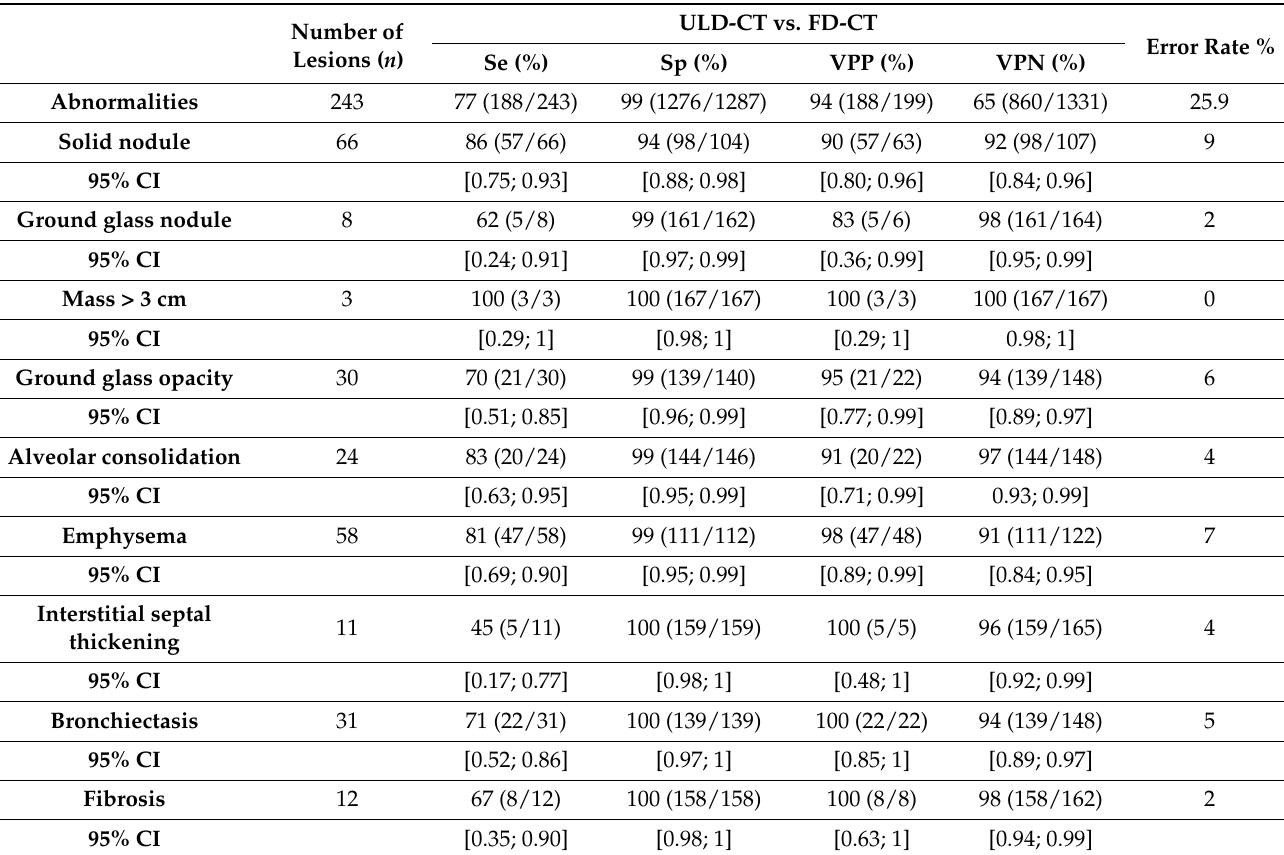
Table 4. Diagnostic performance of